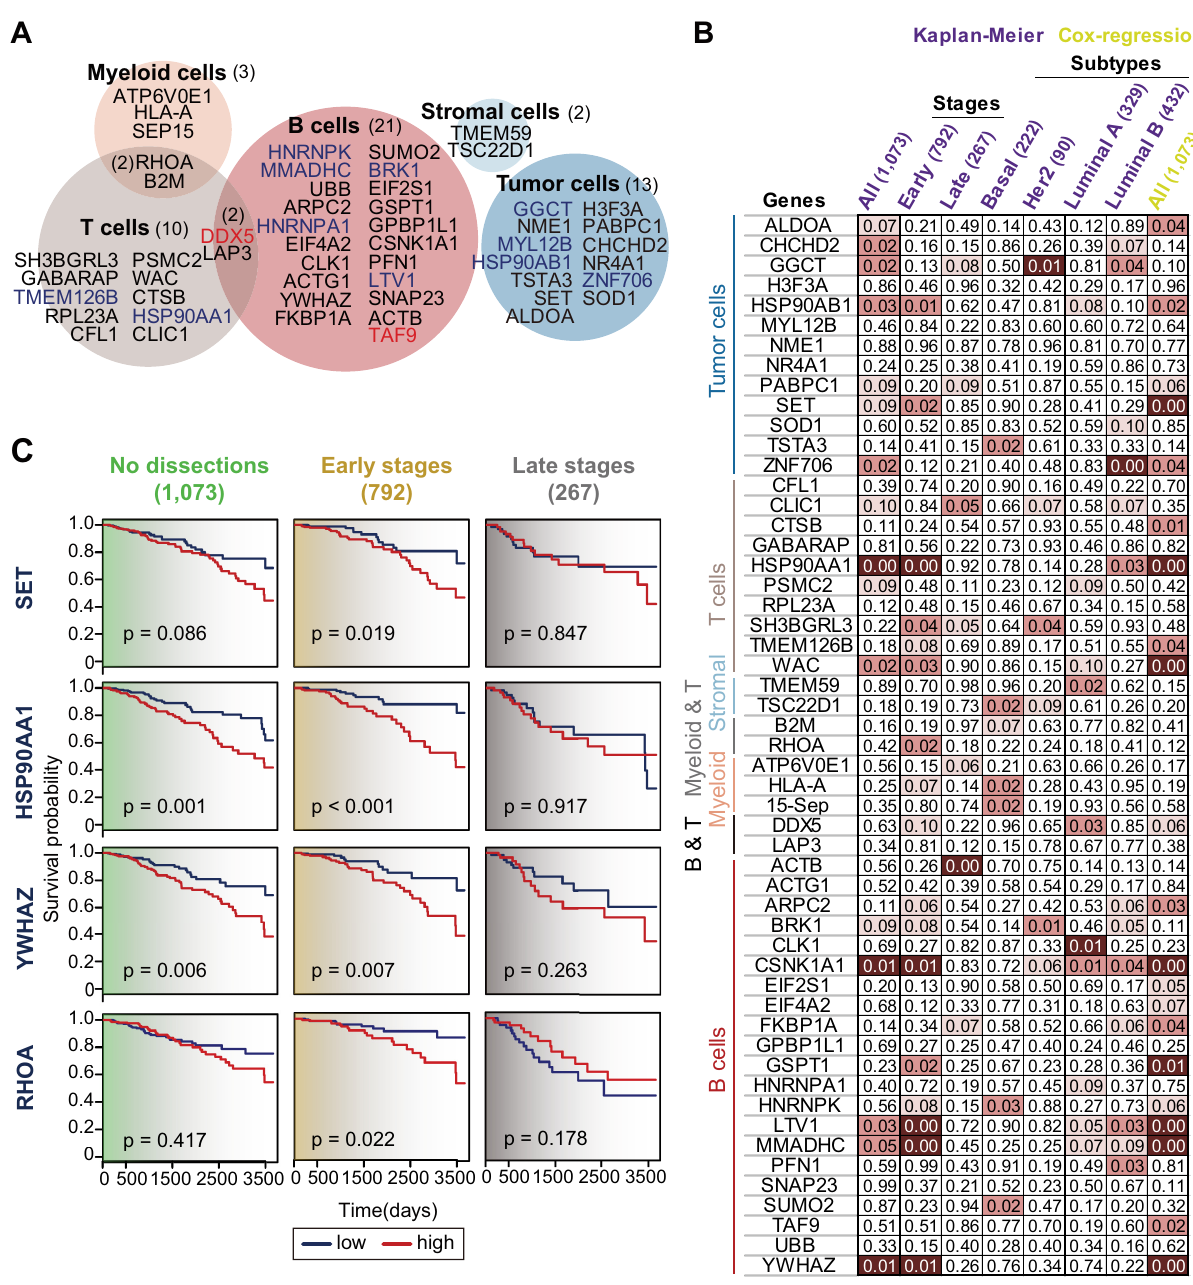
Fig 5. Cell type specific genes with clinical associations. (A) Venn diagram for 53 gene hits specific to 5 cell types. Red-colored genes were concurrently identified in the results of Roar. Blue-colored genes are de novo markers not predefined in a public APA database. Number in the bracket indicates the number of gene hits in each cell type category. (B) Kaplan-Meier and Cox regression analyses for 53 genes in TCGA BRCA patients. Variables showing a significant difference in survival rate are highlighted in symbols (light red; p < 0.01, red; p < 0.05, and dark red; p < 0.1). Number in the bracket indicates the number of tissue samples in each subset. (C) Kaplan-Meier survival plot for SET , HSP90AA1 , YWHAZ , and RHOA in TCGA BRCA patients. The tumor samples were annotated as ‘high’ and ‘low’ (25th and 75th percentiles, respectively) groups for the expression signal of each gene. The p-value was determined by the Log-Rank test. The tumor tissue samples were categorized into early and late cancer stages (Stage I and II / III and IV) based on the ‘pathologic_stage’ information in the clinical dataset. Number in the bracket indicates the number of tissue samples in each